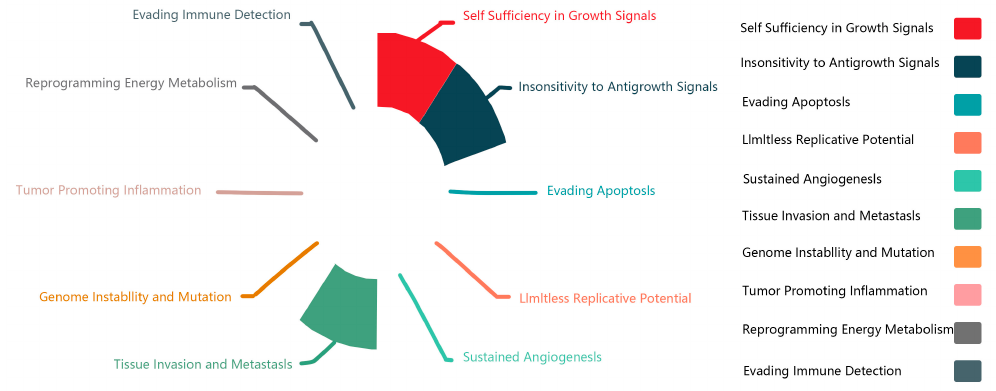
Figure 3. Physiological characteristics of MALAT1 in various types of cancer.